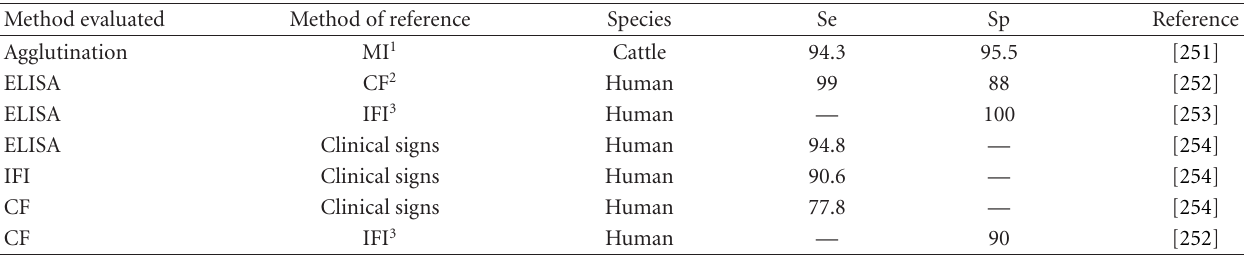
Table 1: Relative epidemiological sensitivity and specificity (%) for di ff erent diagnostic